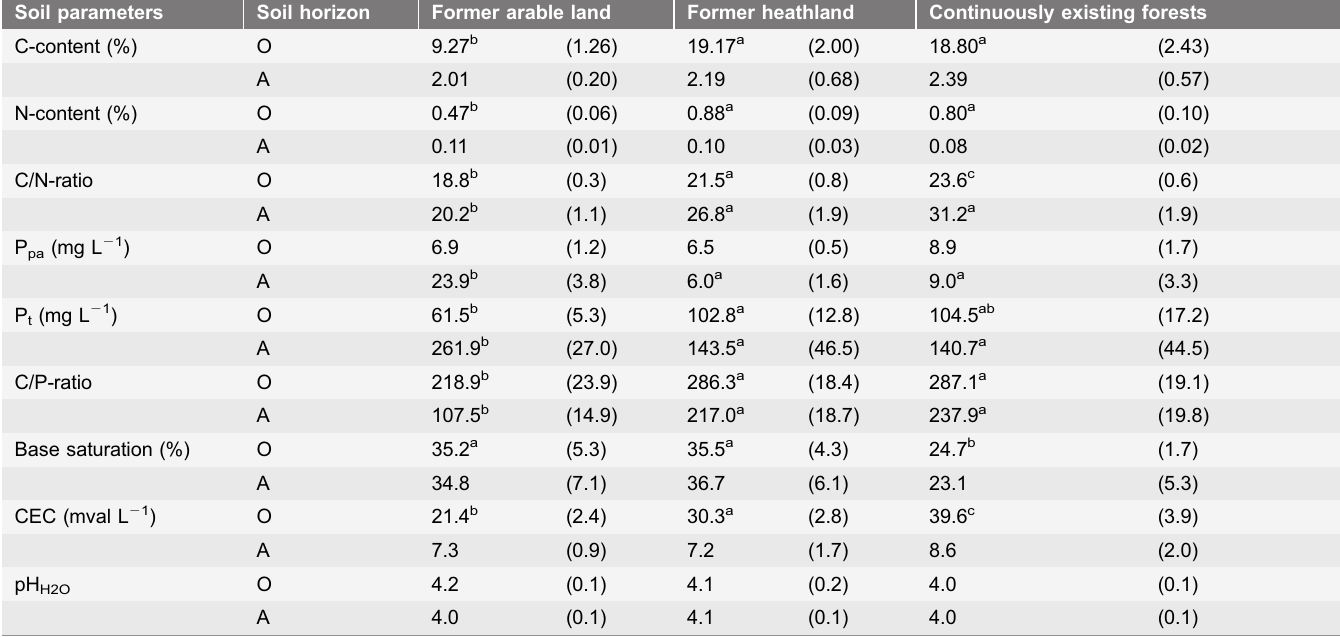
Table 2. Soil ecological properties of the three historical land-use types (means and SD; n 5 10 sample sites per site type; all data from von Oheimb et al. [15]). Soil parameters Soil